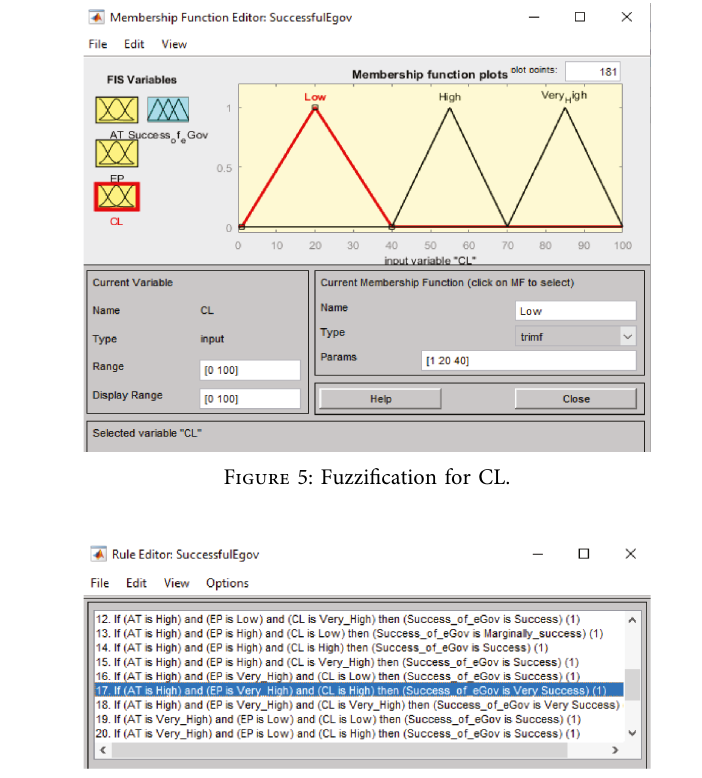
Figure 6: Rule base developments.